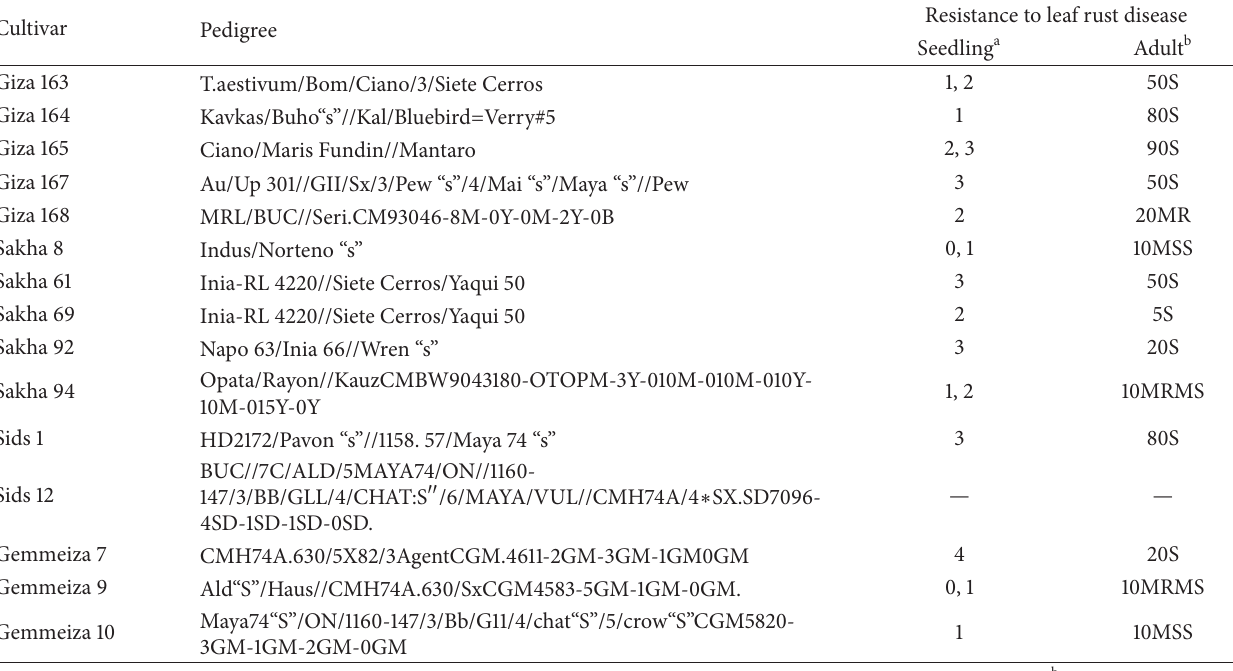
Table 3: Wheat cultivars tested at seedling and adult plant stages for resistance to leaf rust disease. Cultivar Pedigree